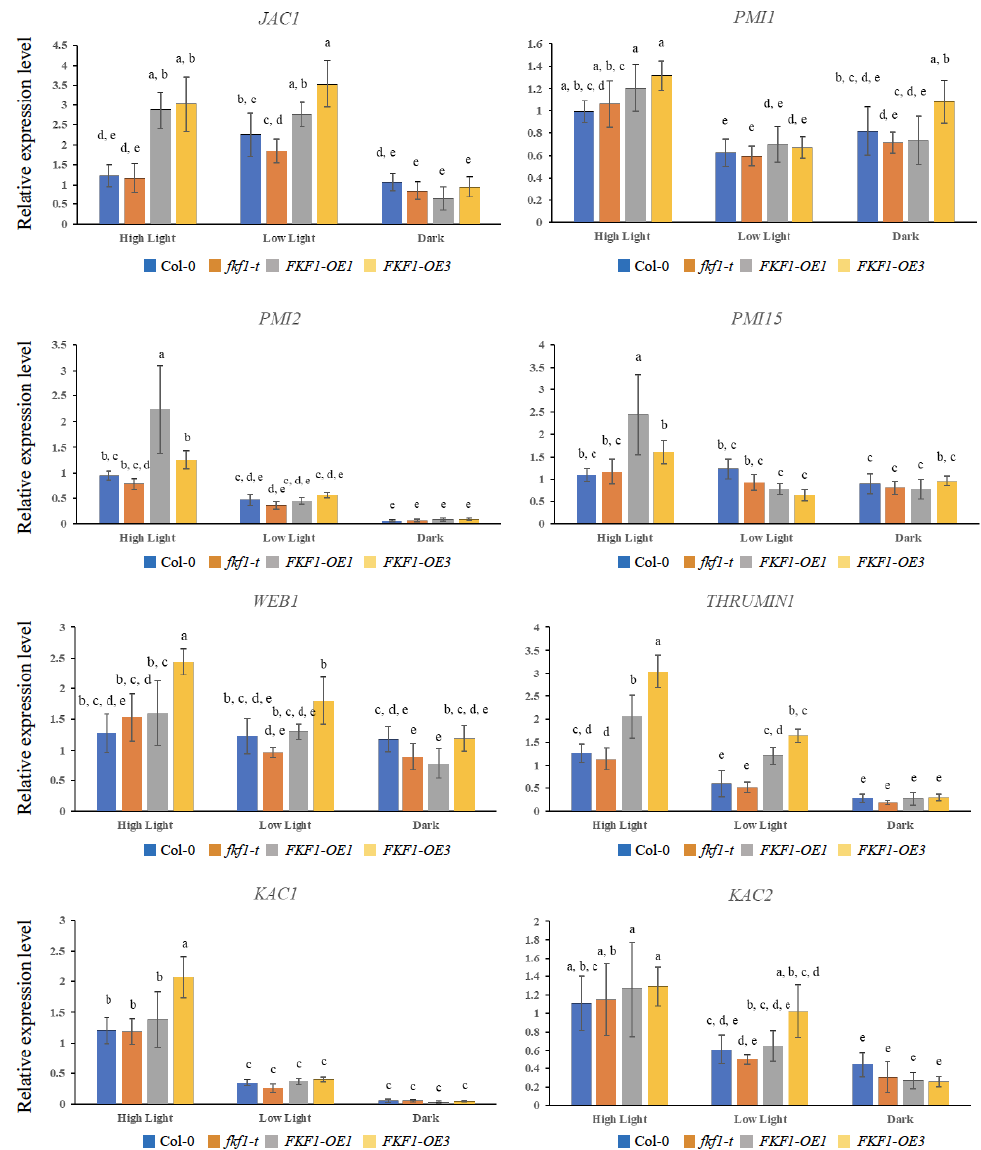
Figure 6. Expression analyses of critical genes involved in the chloroplast photorelocation under white light. Arabidopsis plants grown under white light for 3 weeks were transferred to high light (120 µmol/m 2 /s), low light (10 µmol/m 2 /s), or dark for 6 h (6 h after dawn). Leaf samples were then collected and used for qPCR analysis. The data are an average of two technical replicates from three biological replicates. Error bars represent S.D. ( n = 3). One-way ANOVA, followed by post-hoc analysis using Tukey’s test, was used to determine the statistically significant differences between Arabidopsis lines. Means not sharing the same letter are significantly different ( p < 0.05) or highly significantly different ( p < 0.01). Actin2 was used as a reference gene.